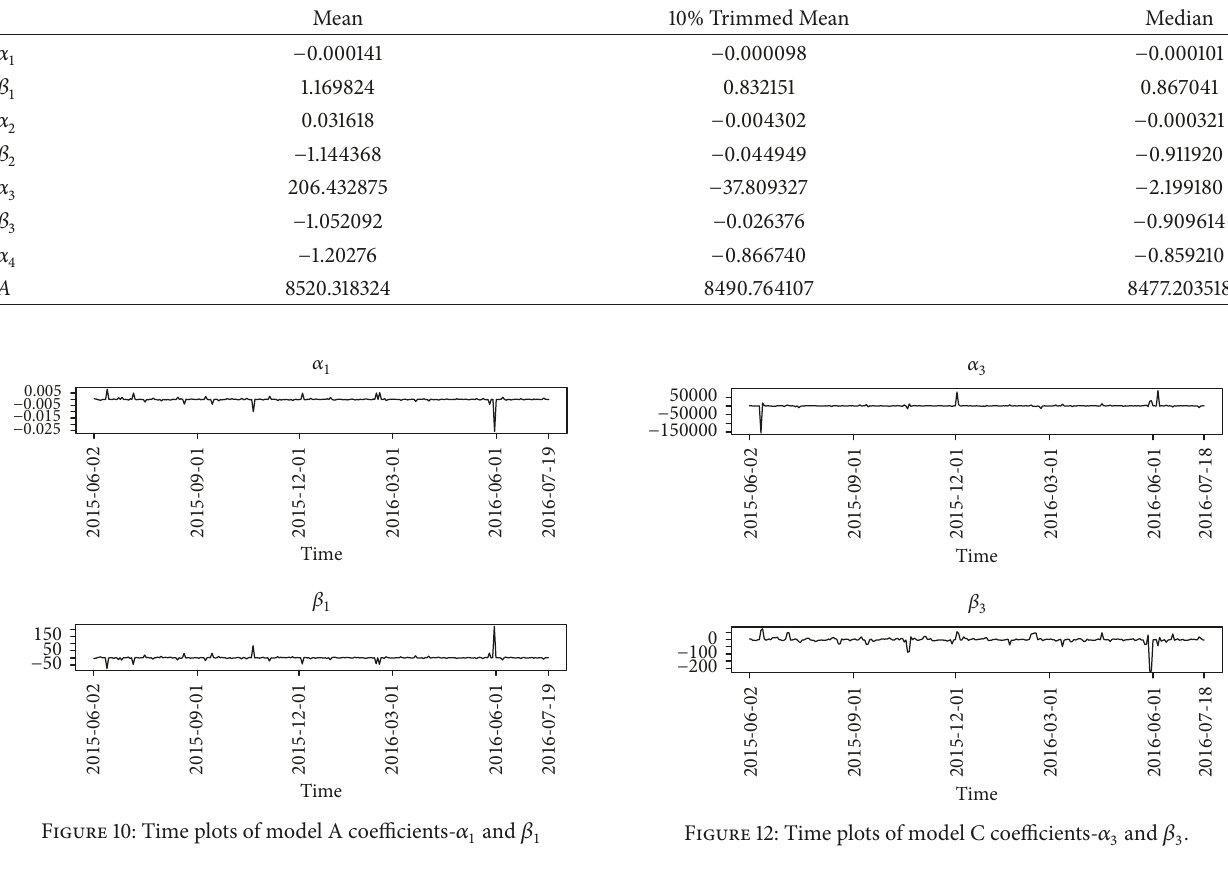
Table 5: Centering tendency of the dynamic model coefficients.